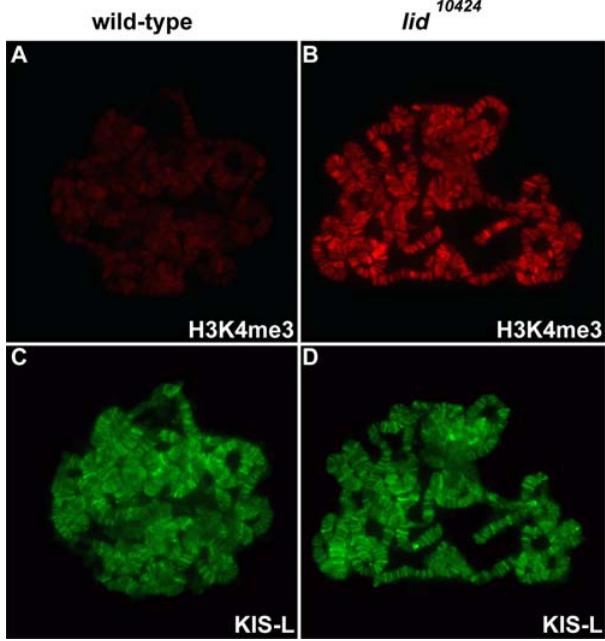
Figure 4. The association of KIS-L with chromatin is not altered in lid mutants. A–D) The levels of H3K4me3 (A, B, red) and KIS-L (C, D, green) on polytene chromosomes isolated from wild-type (A, C) and lid 10424 (B, D) larvae were examined by indirect immunofluorescence microscopy. Loss of lid function led to a dramatic increase in H3K4me3 without affecting the level of KIS-L associated with chromatin.